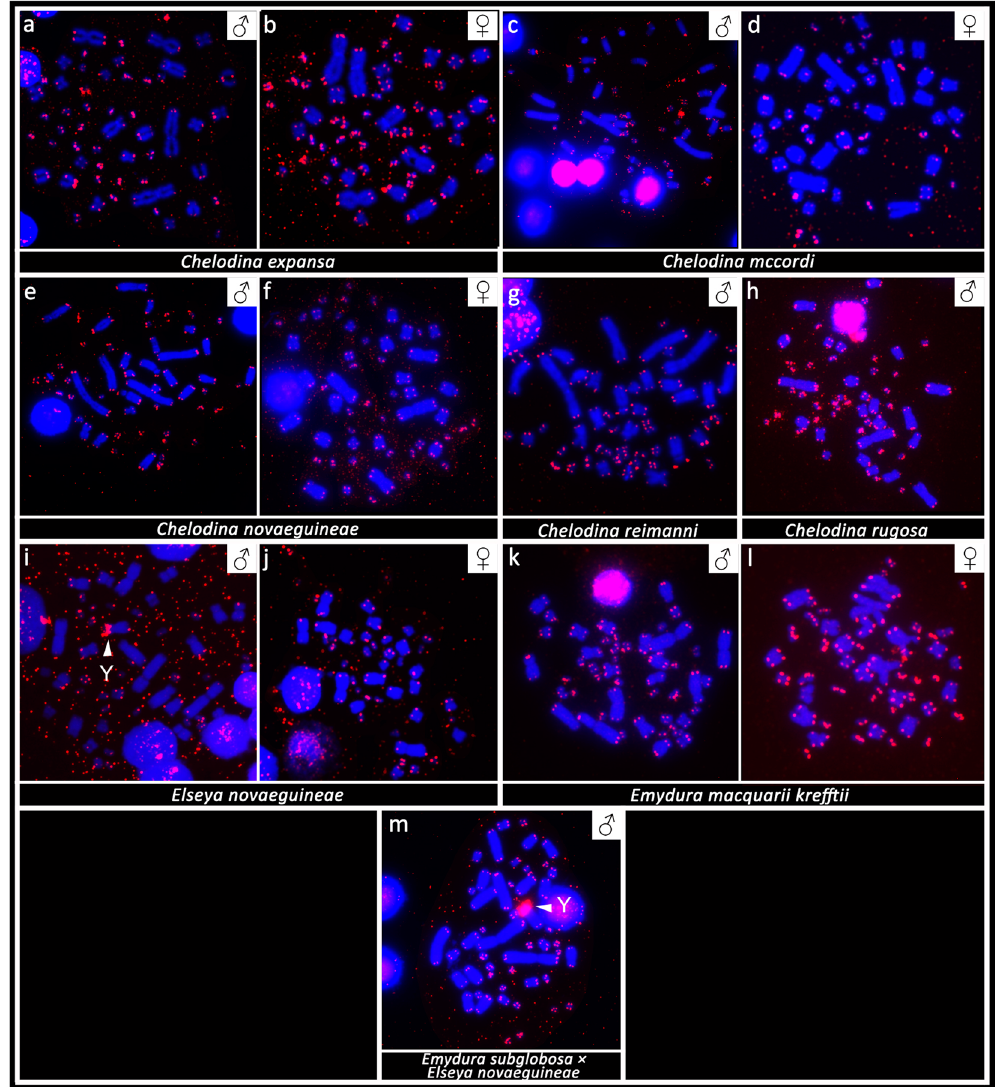
Figure 1. In situ hybridization with probe specific for the (TTAGGG)n telomeric motif in Chelodina expansa ( a ,b), Chelodina mccordi ( c,d ), Chelodina novaeguineae ( e,f ), Chelodina reimanni ( g ), Chelodina rugosa ( h ), Elseya novaeguineae ( i,j ), Emydura macquarii krefftii ( k,l ), and the hybrid Em. subglobosa × El. novaeguineae ( m ). The FITC signal was pseudocolourized in red. All metaphases were counterstained with DAPI (blue). The Y chromosome is indicated with a white